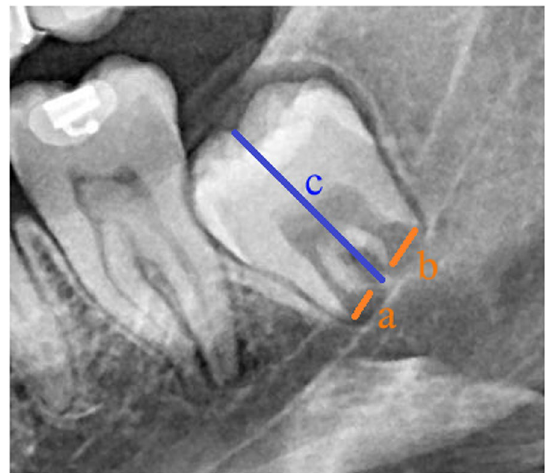
Fig. 2 The third molar maturity index evaluation method is depicted in this image. The orange lines ( a and b ) depict the distance between the root apices, whereas the blue line represents the whole length of the tooth ( c